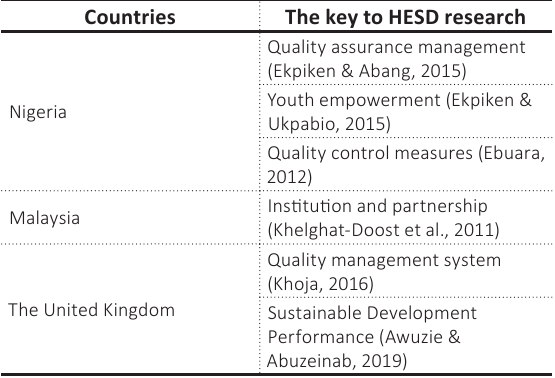
Table 1. Representative countries and contributions to